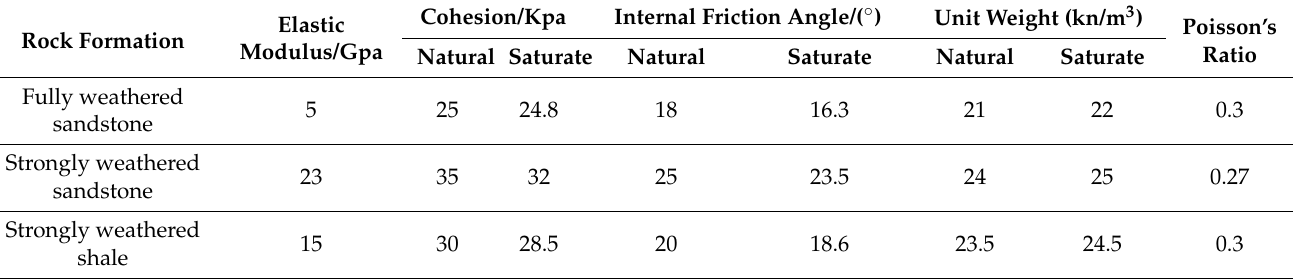
Table 3. The mechanical parameters of the rock mass.